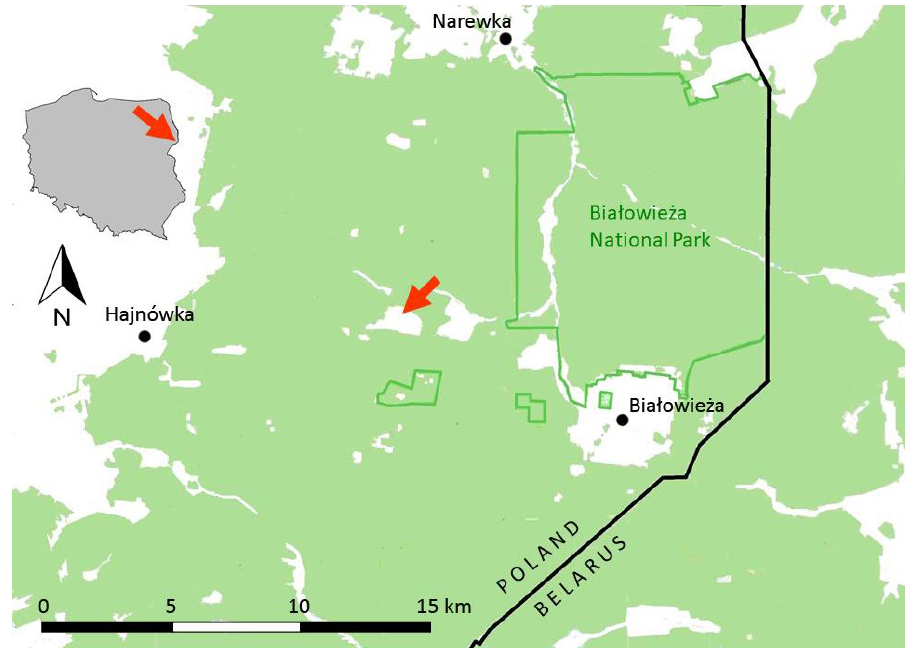
Figure 1. Outline map of the Białowieża Forest (NE Poland) with the location of the study site (red arrow). The color green represents area covered by forest.